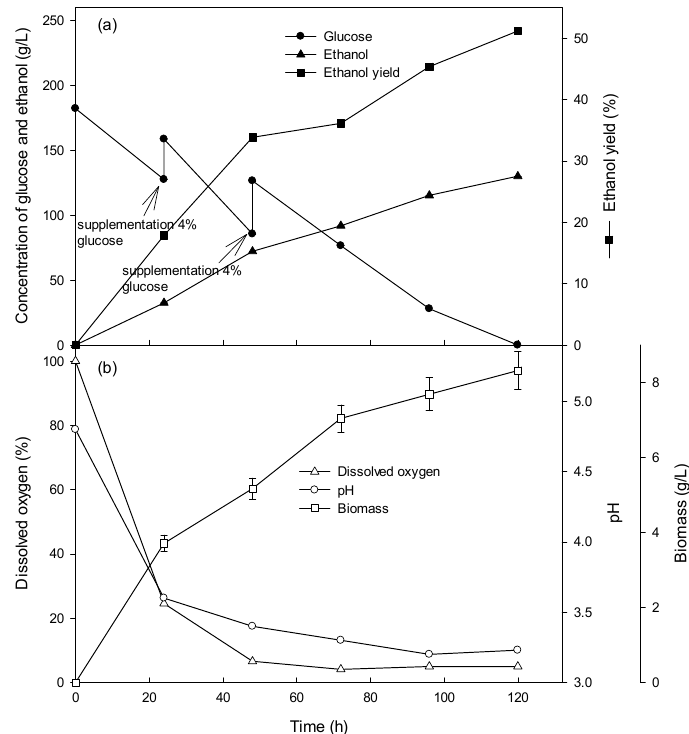
Figure 6. Time course of ( a ) glucose, ethanol concentration, and ethanol yield change, ( b ) dissolved oxygen, pH, and biomass in the fed-batch cultures of S. cerevisiae BCRC 21812. The glucose concentration in the fermentation media was initially 18% ( w / v ) with an addition of 4% ( w / v ) glucose after one and two days of incubation, respectively.